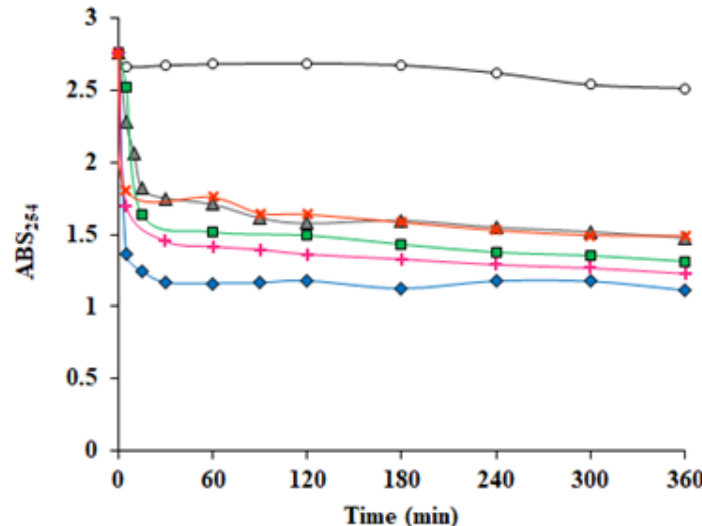
Figure 8. Evolution of ABS 254 values with time in absence of catalyst ( ), in presence of the eggshell ( (cid:78) ) and the supported catalysts: Fe 5% ( + ), Fe 15% ( × ), Cu 5% ( (cid:4) ), and Cu 15% ( (cid:7) ). In all cases, T = 150 ◦ C, P = 40 bar, pH = 7.5, initial HA concentration = 400 ppm and catalyst concentration = 1 g/L.